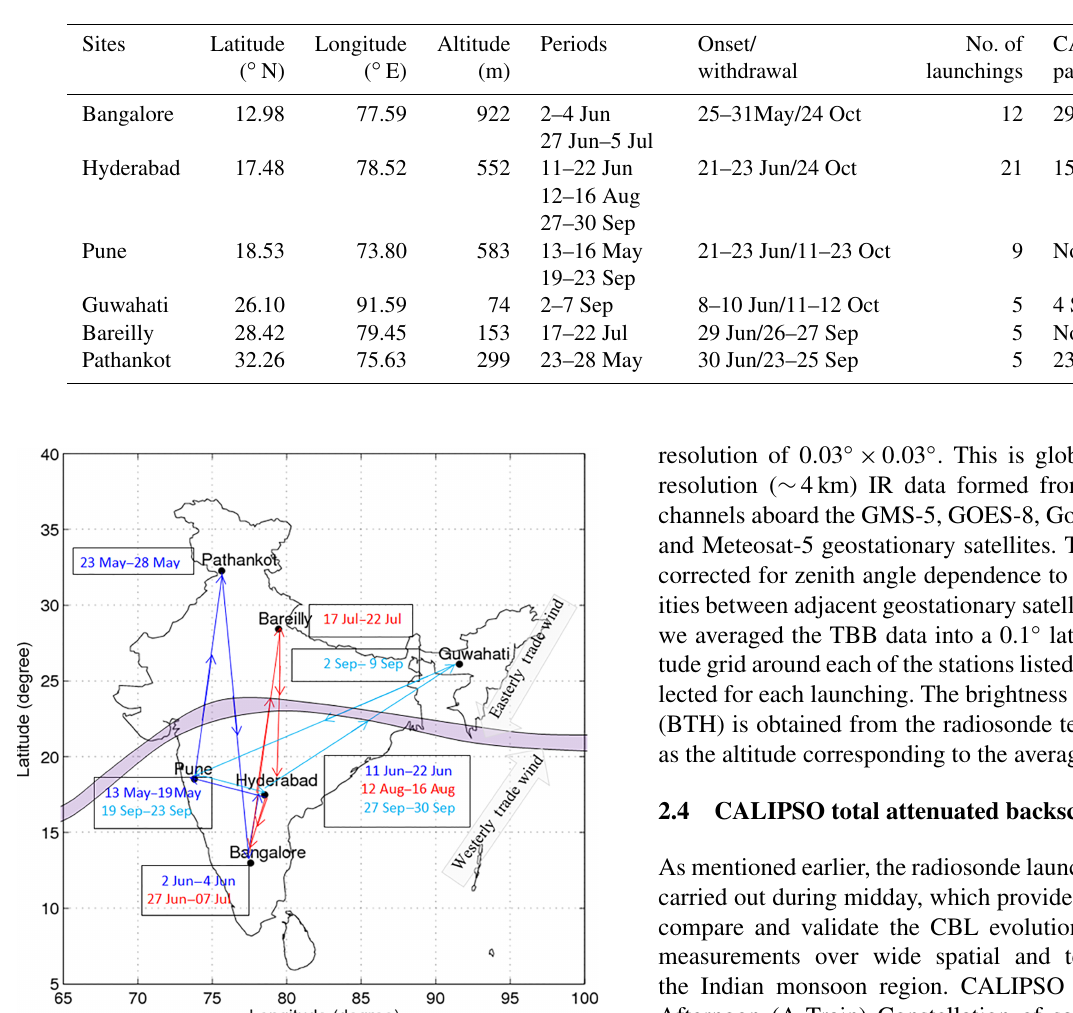
Table 1. List of sites where radiosonde launchings were conducted under the CAIPEEX campaign during May–September 2009 with the latitude, longitude, and altitude of the launching sites above mean sea level; periods of observation; and numbers of launchings. The dates of monsoon onset and withdrawal and of the simultaneous CALIPSO and radiosonde observations are also listed.